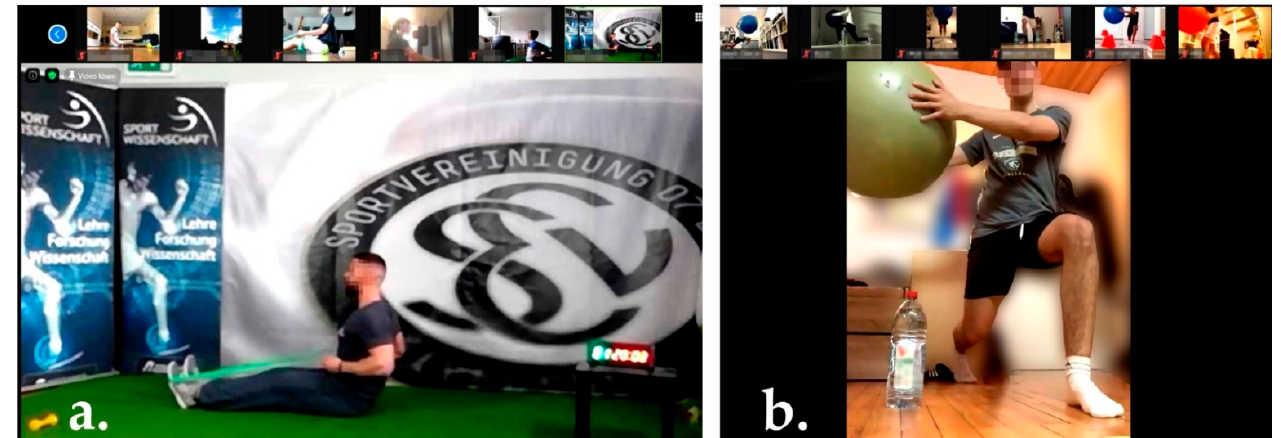
Figure 2. Exemplary online view that the participants ( a ) and the correcting trainers ( b ) had during the exercise sessions. In the photo on the right, the background has been changed for data protection reasons. The persons depicted have given their written consent to the publication of the photos. Table 2. Prevalence of postural deviations in the studied population (absolute N/prevalence).